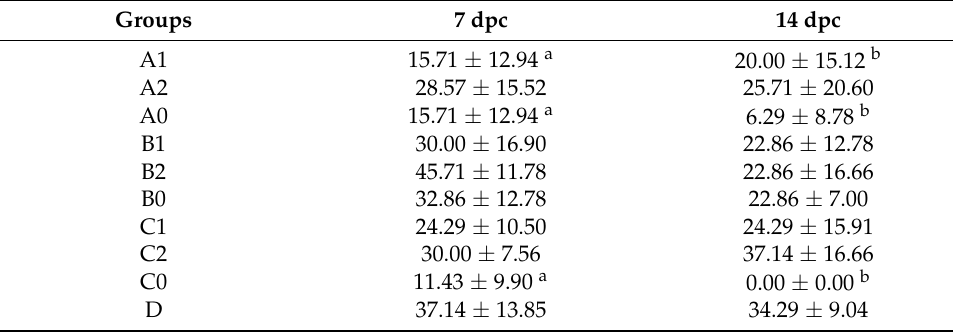
Table 2 . Egg production rate after challenged with Av. paragallinarum .